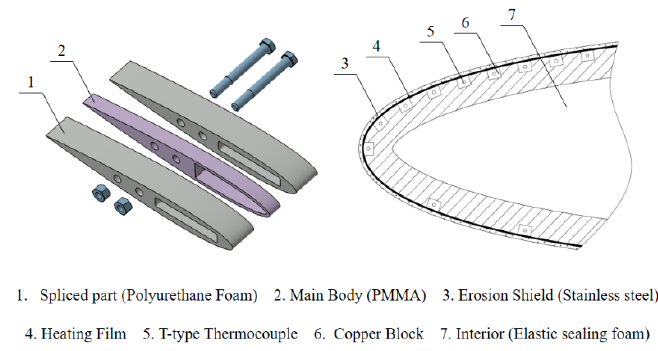
Figure 5. Structure of the test model.